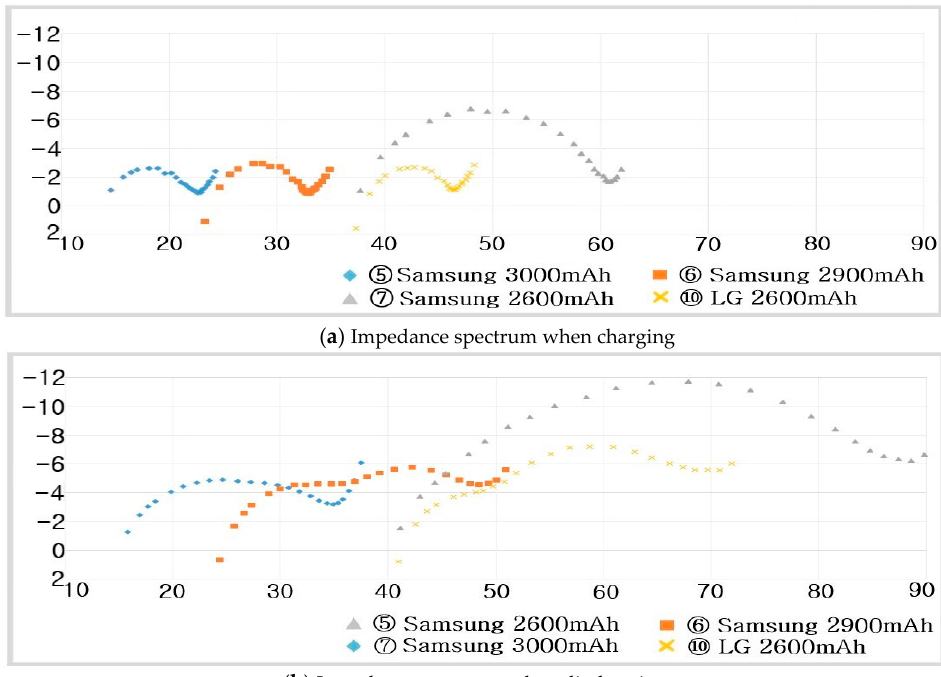
Figure 17. Equivalent circuit and typical curve fitting.